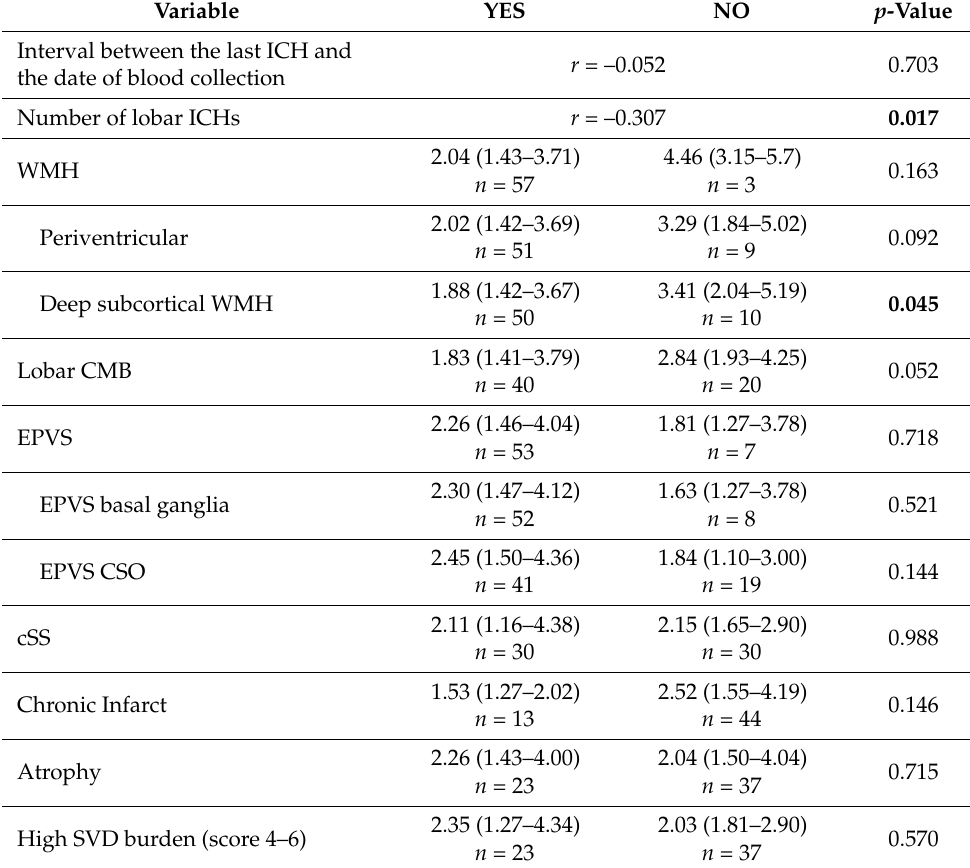
Table 4. Univariate analysis of AQP4 levels according to CAA–ICH radiological